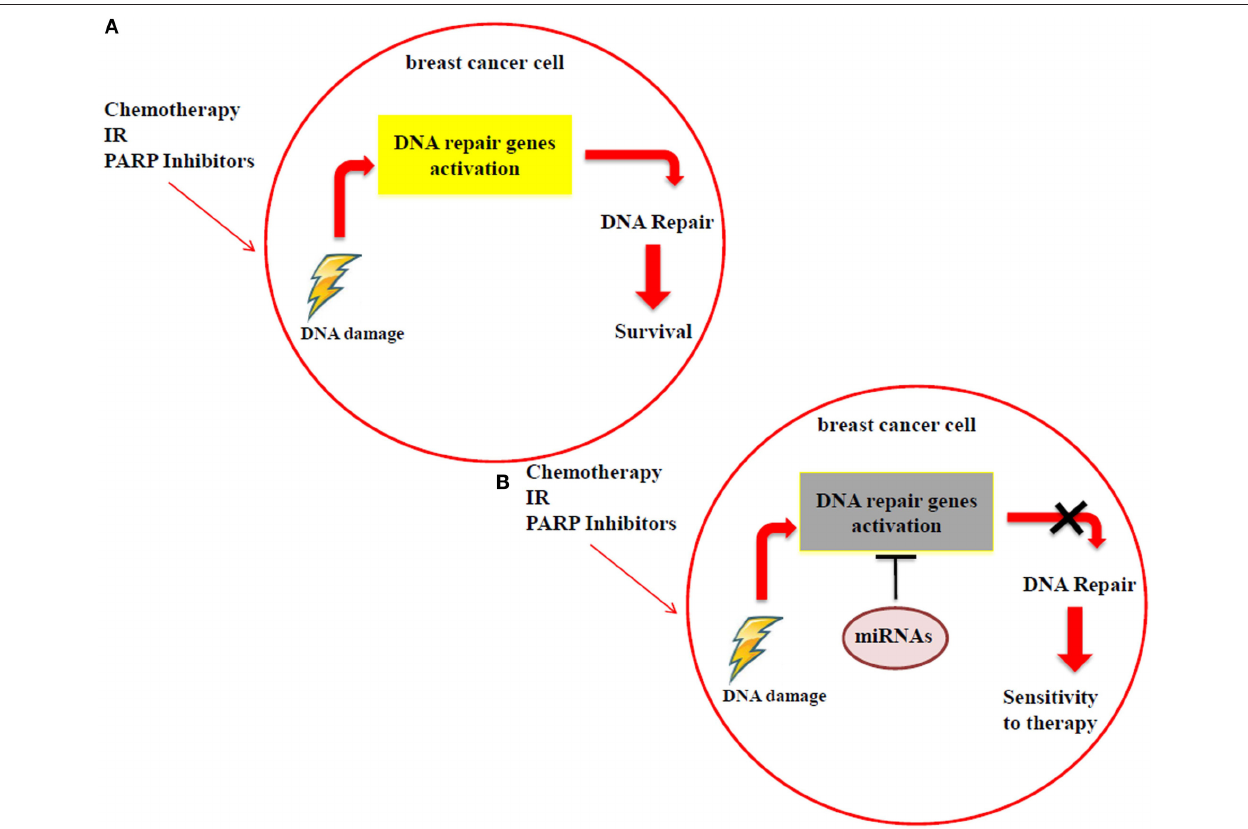
FIGURE 2 | (A) Breast cancer cells can still repair the DNA damage, caused by radiotherapy, chemotherapy and PARP inhibitor treatments, using DDR mechanisms. (B) MiRNAs impair the activation of DDR mechanisms by targeting DNA repair genes, improving the sensitivity to radiotherapy, chemotherapy and PARP inhibitors.